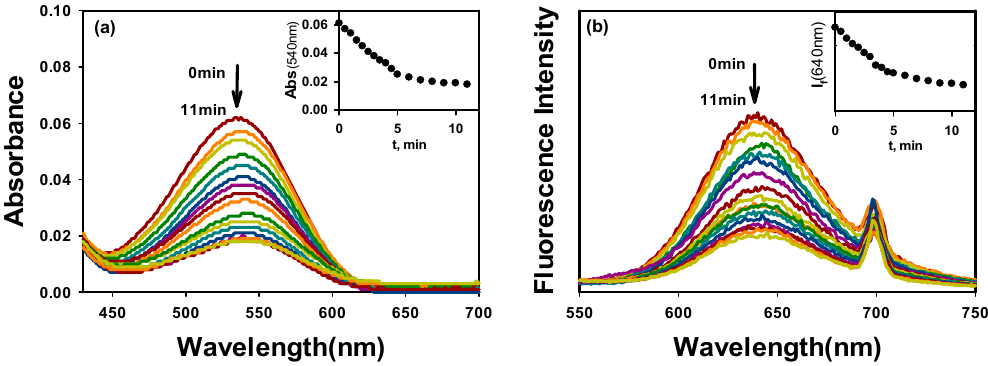
Figure 4. ( a ) Absorption and ( b ) fluorescence spectral changes by reverse reaction from MC-IQ (formed after dark incubation of SP-IQ for 7 h) to SP-IQ with time (0–11 min, Different color lines represent different times.) under room illumination. Inset: Plots of ( a ) absorbance at 540 nm and ( b ) fluorescence intensity at 640 nm vs. room illumination time.